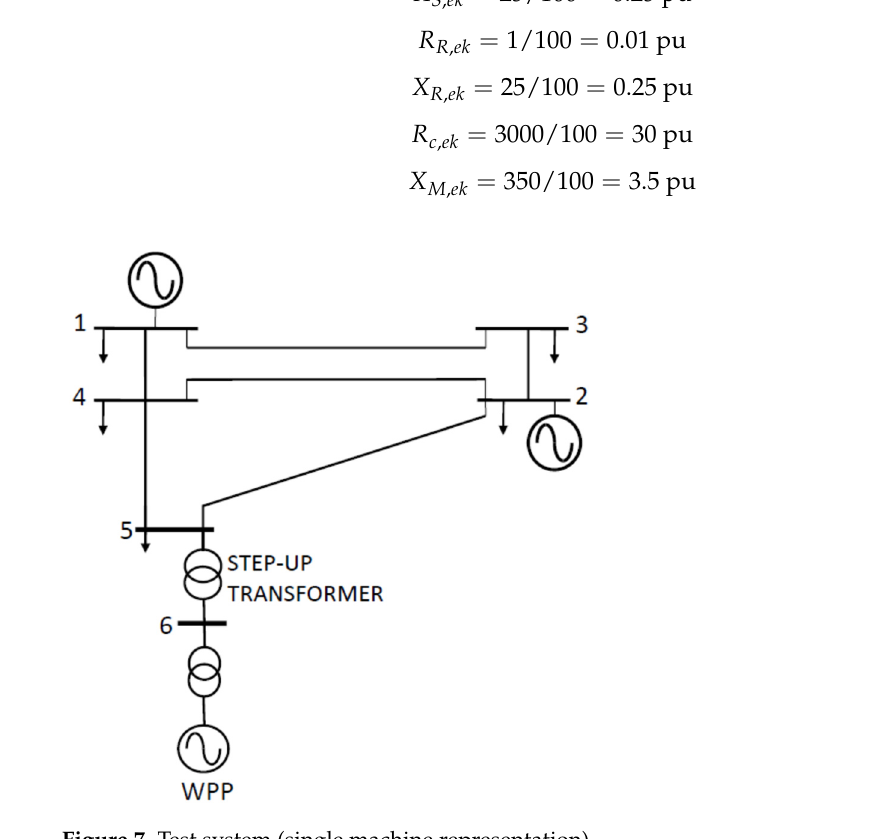
Figure 7. Test system (single machine representation).